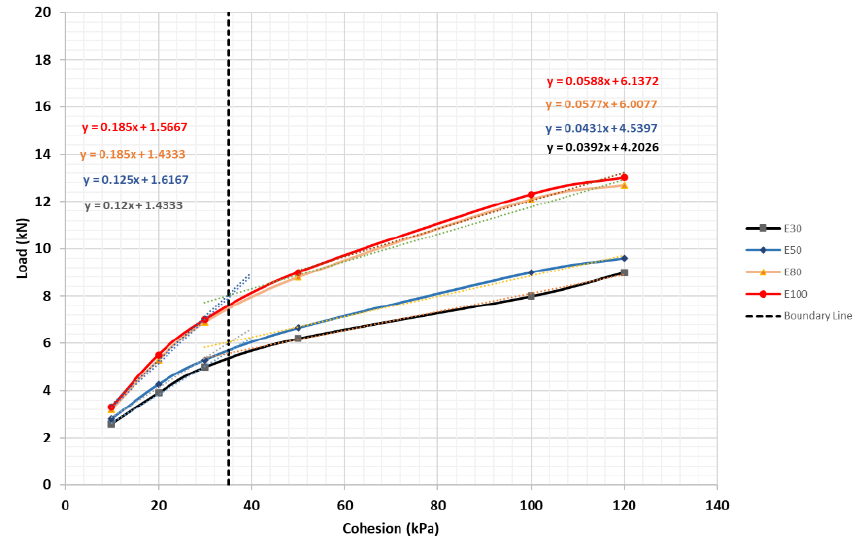
Figure 5. Relationship between cohesive force and ultimate bearing capacity for CHSB 0 pile.